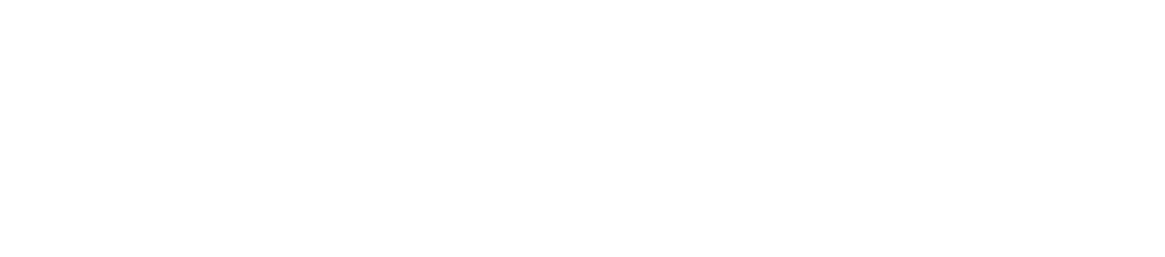
FIGURE 2 | Process to establish climate ready objectives in future fl ow assessements.